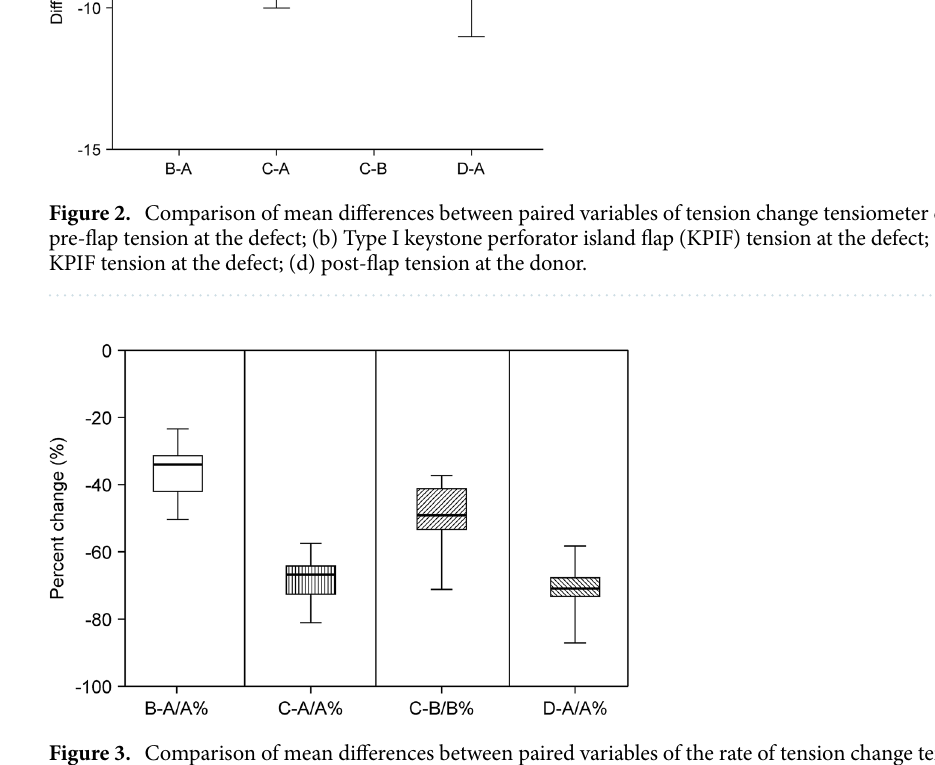
Figure 3. Comparison of mean differences between paired variables of the rate of tension change tensiometer data. (a) pre-flap tension at the defect; (b) Type I keystone perforator island flap (KPIF) tension at the defect; (c) Type II KPIF tension at the defect; (d) post-flap tension at the